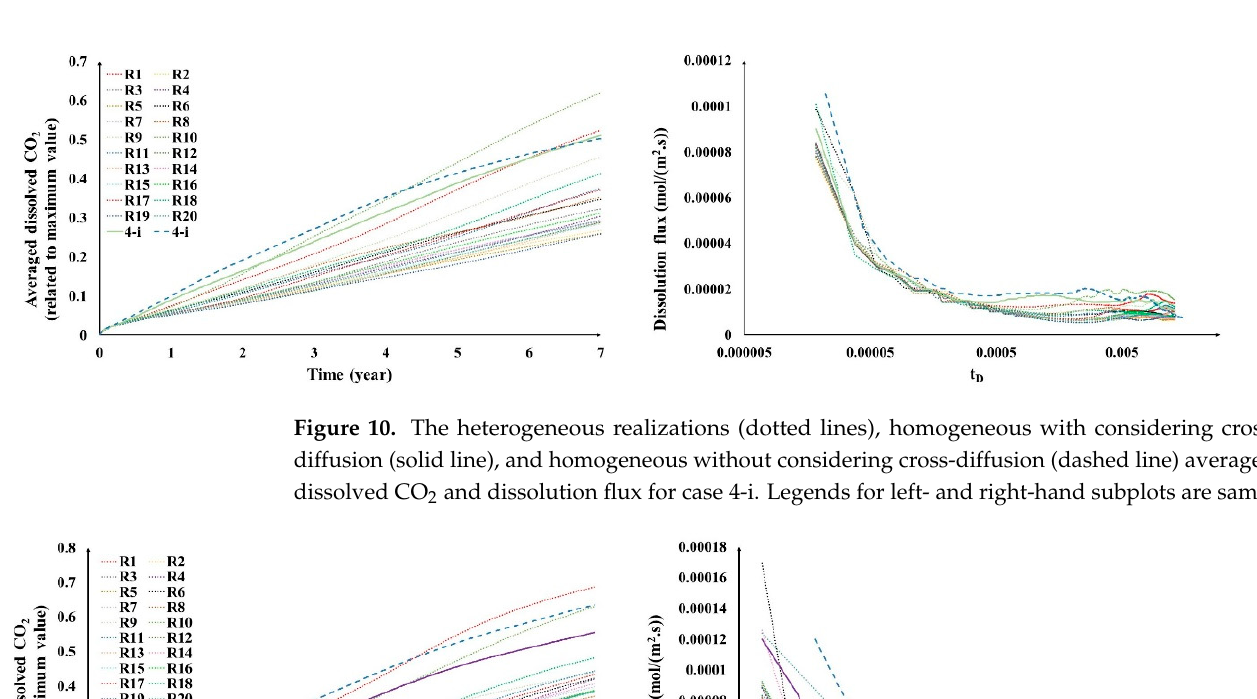
solved CO 2 and dissolution flux for case 3-i. Legends for left- and right-hand subplots are same.